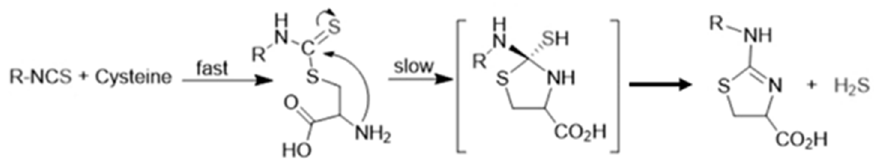
Figure 3. Schematic representation of the reaction between cysteine and organic isothiocyanates (ITCs) leading to the formation of H 2 S.